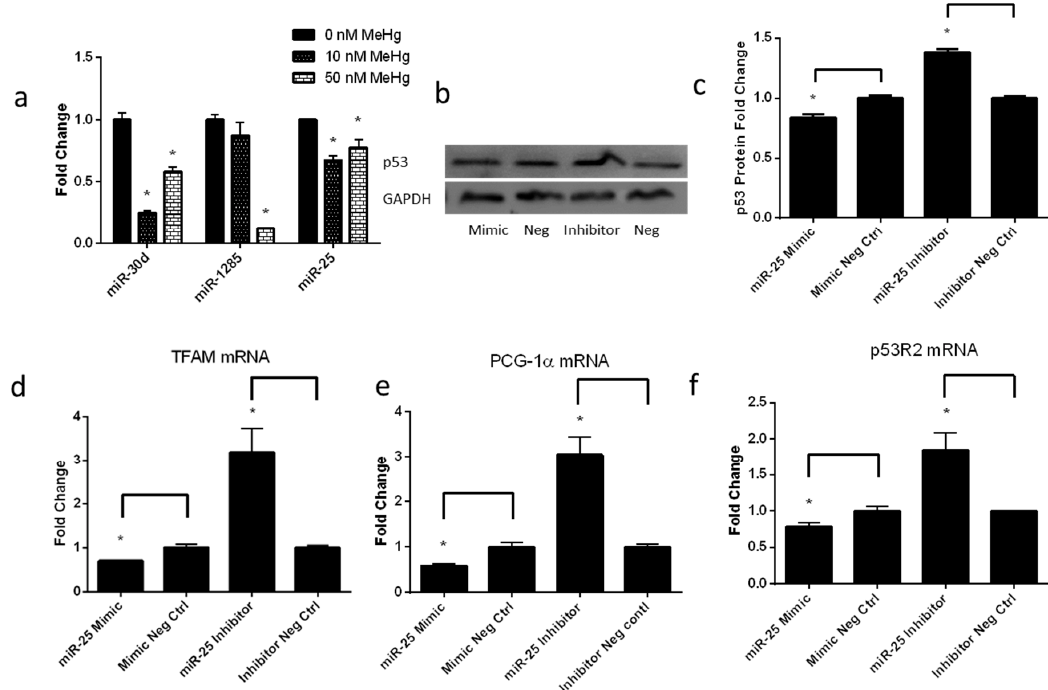
Figure 5. Low-level MeHg induces genes regulating mitochondrial biogenesis via miR-25. ( a ) qPCR analysis of mature miR-30d, miR-1285, and miR-25 expression levels performed on RNA extracted from ihNPCs treated with 0 nM, 10 nM and 50 nM MeHg; ( b ) A representative Western blot of p53 expression in ihNPCs. Cells were transfected with 50 nM of miR-25 mimics, miR-mimic negative control#1, miR-25 inhibitor and miR-inhibitor negative control#1 for 48 h; ( c ) Western blot analysis of p53 expression performed in 10 nM-treated ihNPCs after transient transfection of miR-25 mimics, miR-mimic negative control#1, miR-25 inhibitor and miR-inhibitor negative control#1. Glyceraldehyde 3-phosphate dehydrogenase (GAPDH) protein expression has been used as a loading control and a representative figure of three independent experiments has been shown. Results of gray value analysis are also reported (left part); ( d – f ) qPCR analysis of TFAM, PCG- α and p53R2 expression performed in 10 nM-treated ihNPCs after transient transfection of miR-25 mimics, miR-mimic negative control#1, miR-25 inhibitor and miR-inhibitor negative control#1. All experiments were repeated three times (technical triplicates) with biological triplicates ( n = 3). Bar graphs show mean ± SEM (* p < 0.05).